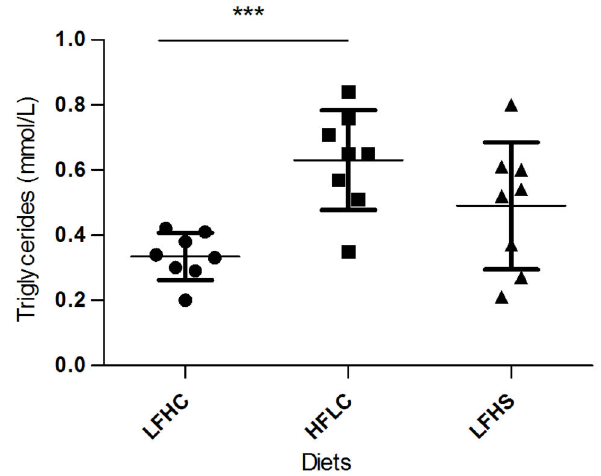
Figure 4. C-reactive protein (CRP) in minipig serum by the end of the study. CRP concentrations (µg/ml) ±SD for minipigs fed low fat, high carbohydrate diet (LFHC); high fat/